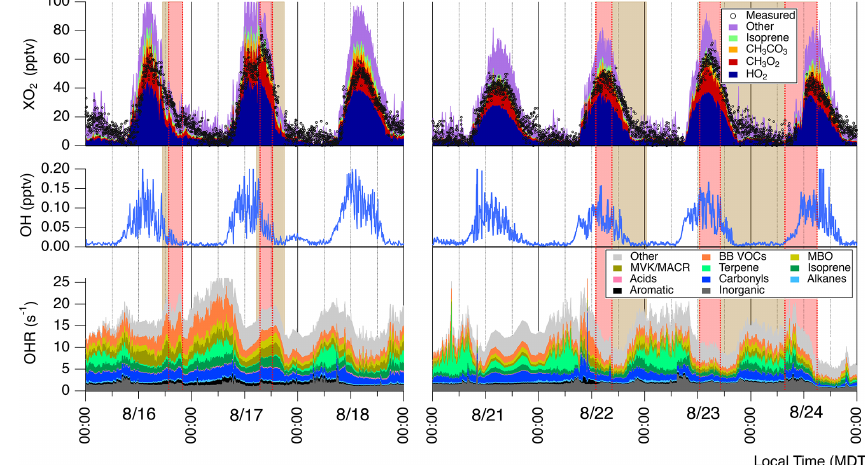
Figure 6. Time series of modeled OH, HO 2 , speciated RO 2 , and OH reactivity (OHR). These results were acquired using the MCM-BBVOC mechanism. Periods of smoke are shaded as per Fig. 2. Measured XO 2 is included as black markers for comparison. Note that the isoprene XO 2 category includes several RO 2 species produced from isoprene